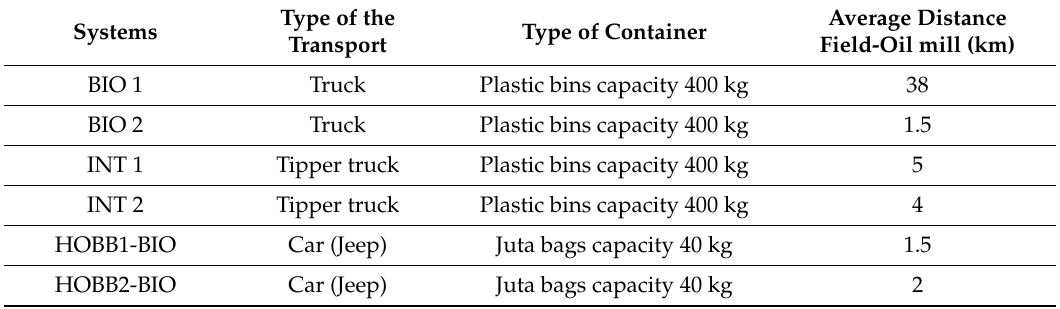
Table 3. Methods of olives transporting from the field to the oil mill in the analyzed